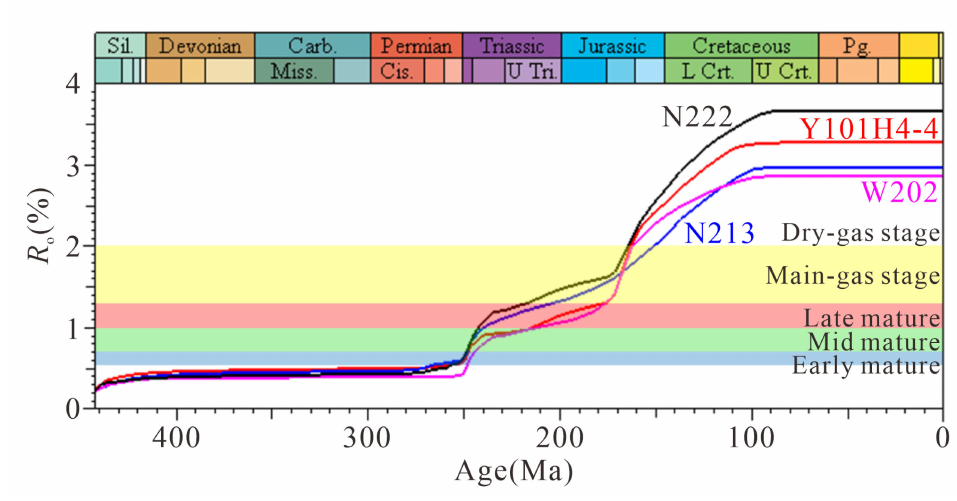
Figure 14. Thermal evolution and hydrocarbon generation history of the Wufeng–Longmaxi Formations in N222, Y101H4-4, N213 and W202